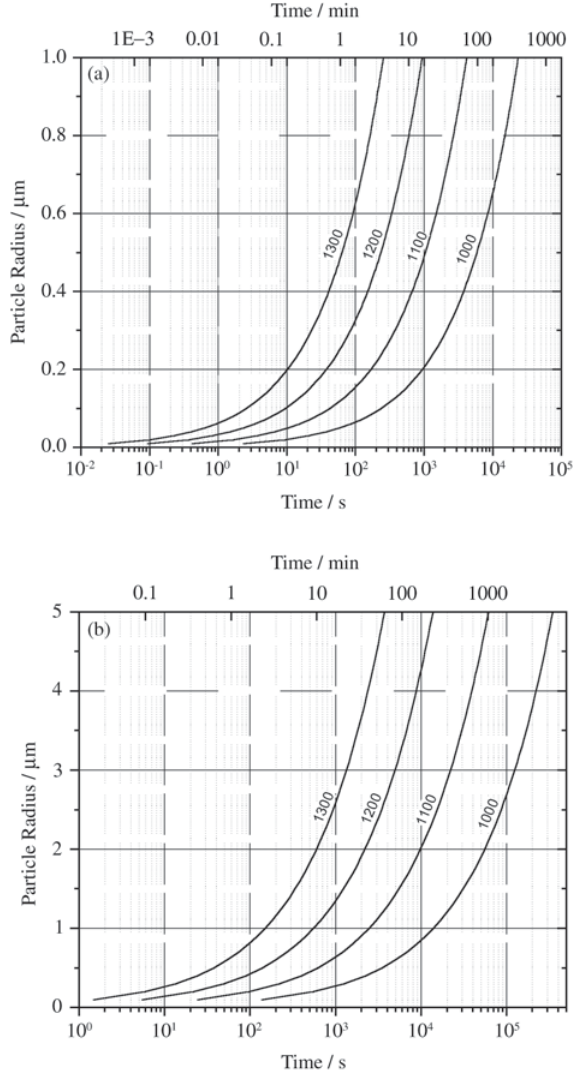
Figure 2. Curves showing the maximum radii of a) M cles and b) (Ti